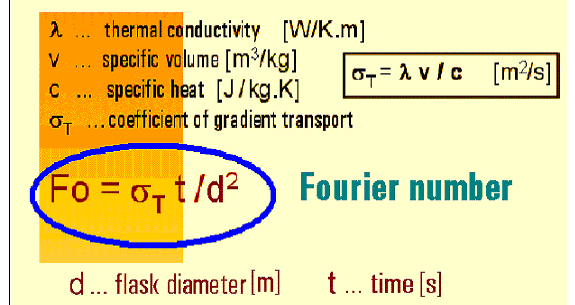
Fig. 14. Fourier number Fo is the governing parameter of unsteady heat transfer processes. It may be expected quite safely that in the discussed case it will be the dimensionless measure of melting and solidification time.